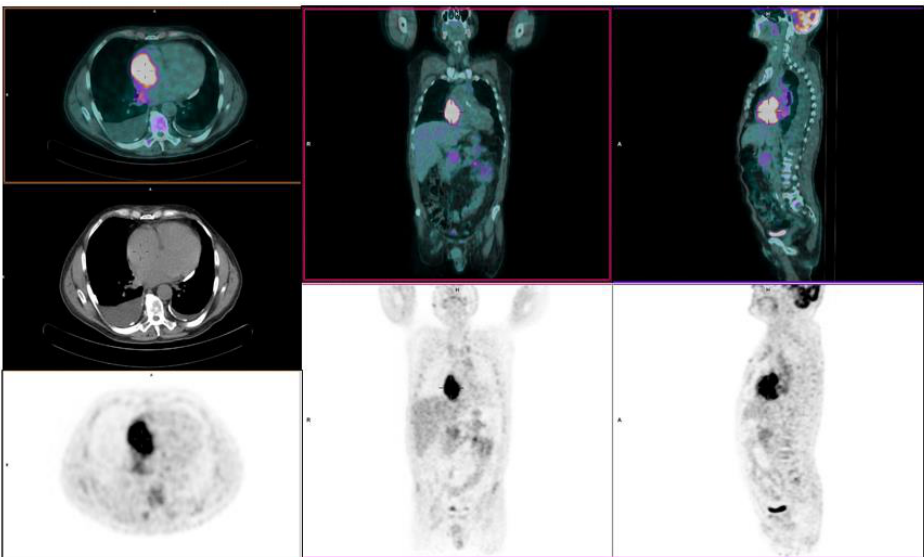
Figure 2. January 2020; 18F-FDG-PET/CT before therapy showing an intense uptake in the right atrium (SUV max 9.4) expression of high metabolic activity. Subsequent biopsy examination confirmed right atrial lymphoma relapse.